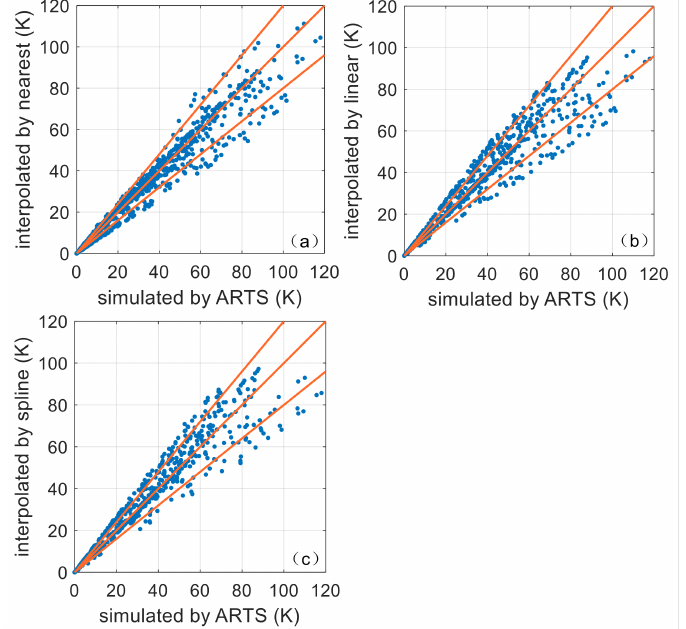
Figure 4. Scatter plots of the brightness temperature differences simulated by ARTS and three interpolation methods: ( a ) nearest, ( b ) linear and ( c )